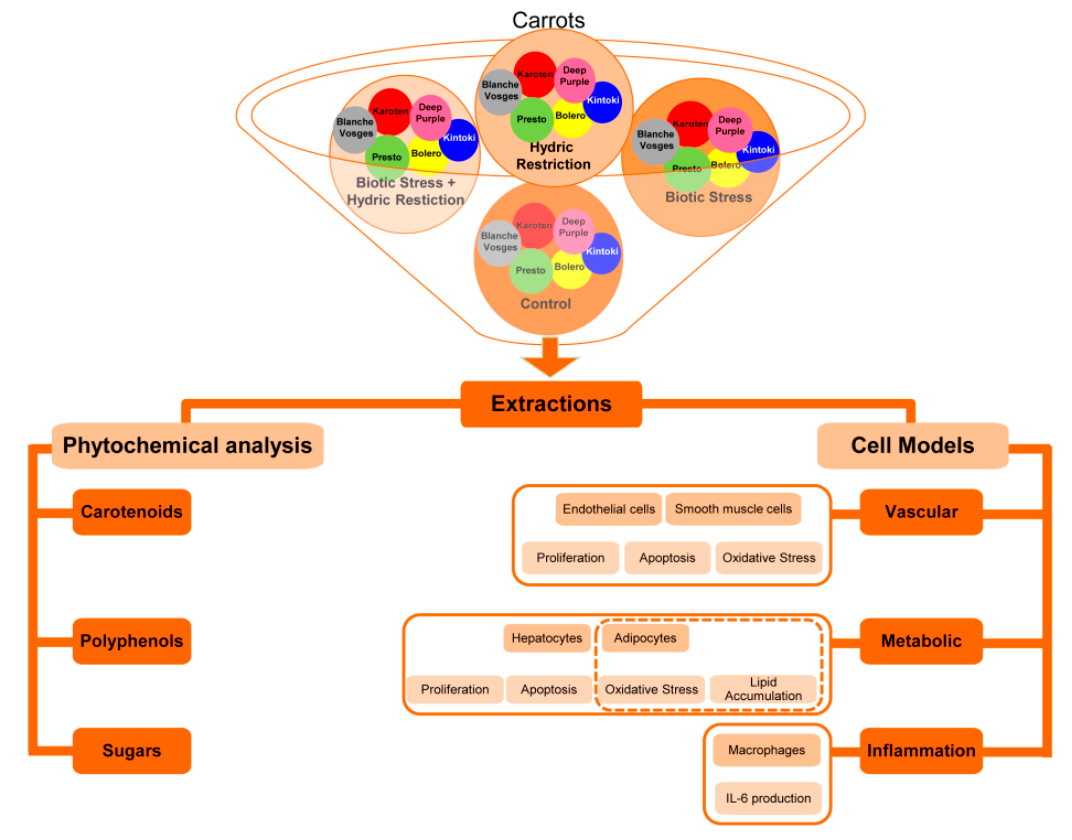
Figure 1. Diagram showing general strategy used during the project. Frozen homogenates from six carrot varieties (Bolero, Presto, Deep Purple, Karotan, Kintoki and Blanche des Vosges) grown in (i) standard conditions (control), (ii) water-restricted condition (hydric stress), (iii) A. dauci